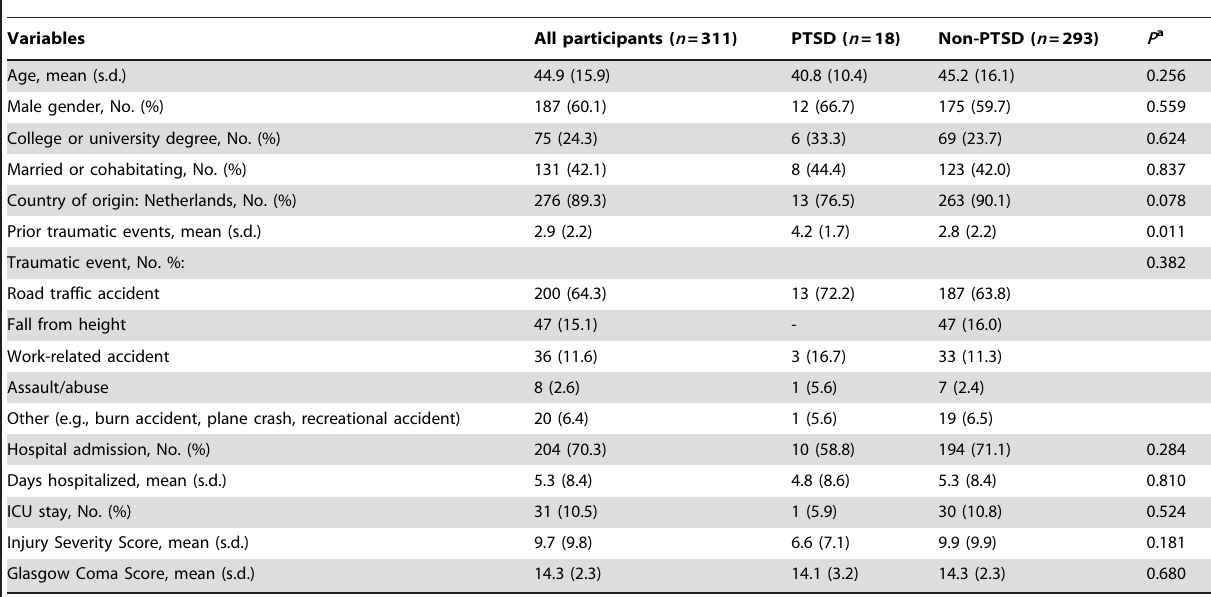
Table 1. Baseline characteristics of the total sample and participants with and without 6 month